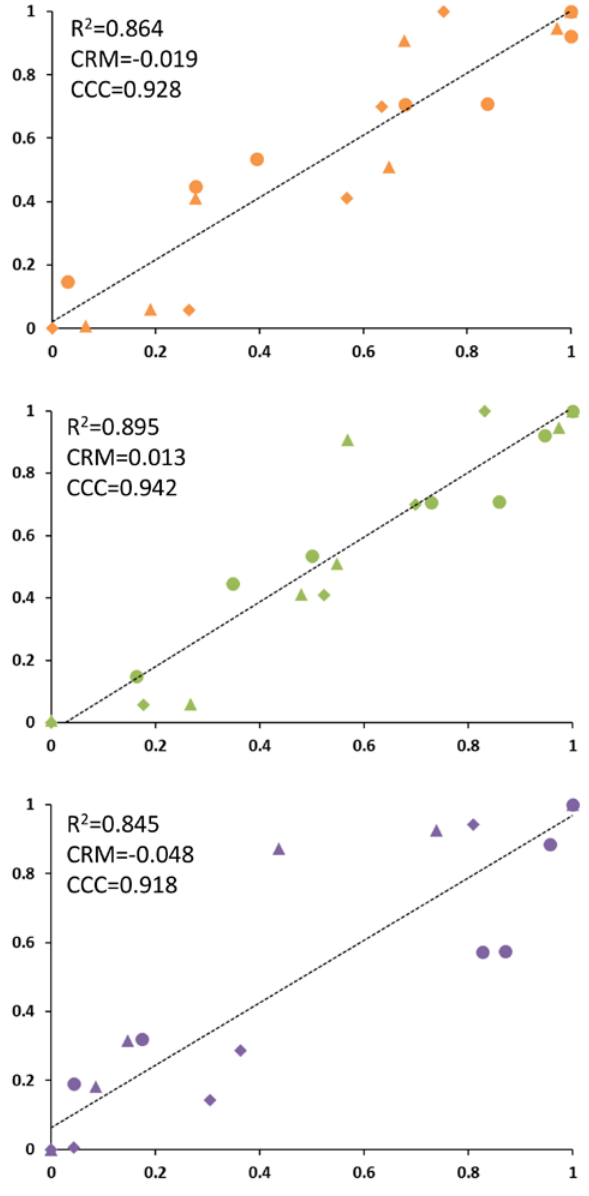
Figure 6. Plots of predicted versus observed values of lo- quat scab fruit infection for cv. Algerie (orange), Peluche (green) and San Filipparo (purple) in 2013 (dot symbols), 2014 (triangle symbols) and 2015 (diamond symbols). Goodness of fit parameters ( R 2 , CRM and CCC) are indi- cated for each